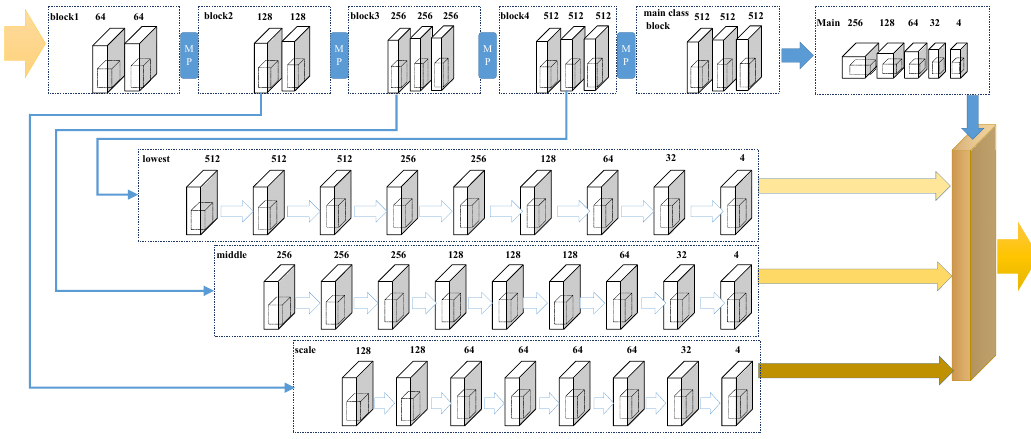
Figure 7. The architecture and weight of